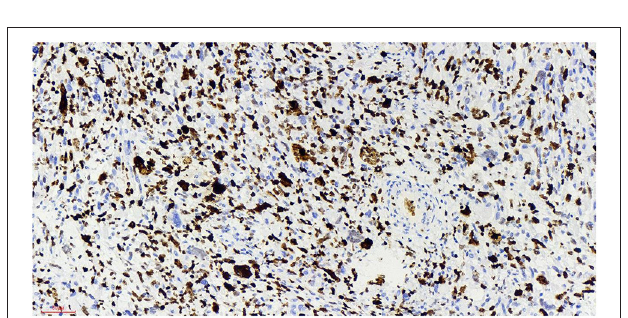
FIGURE 9 | Ki-67 x 20, + , visible nuclear protein staining Ki-67 positive tumor cells diffuse expression, positive rate of